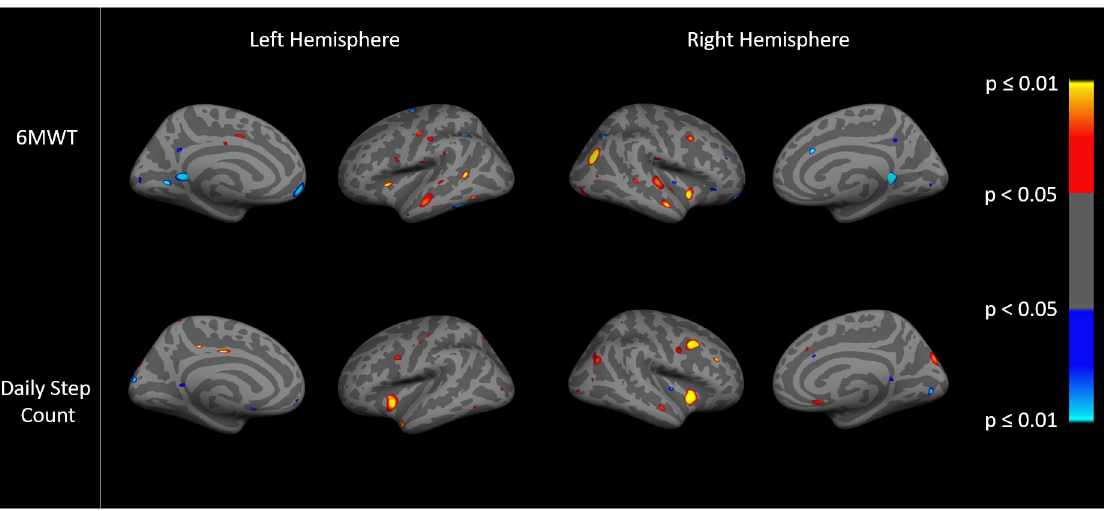
Fig 3. Association between cortical thickness with exercise capacity (6MWT distance) (top) and physical activity (daily step count) (bottom).